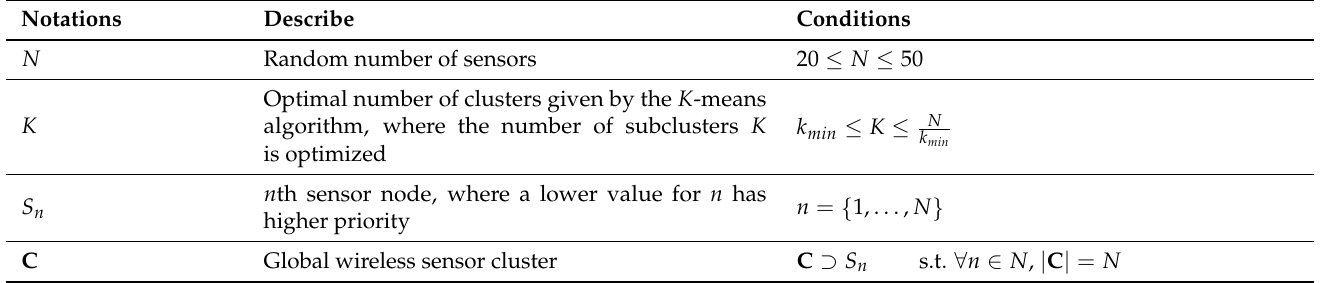
Table 1. List of important